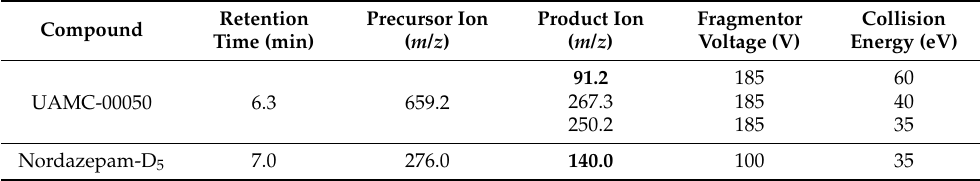
Table 1. Optimized compound-specific mass spectrometric parameters for pharmacokinetic